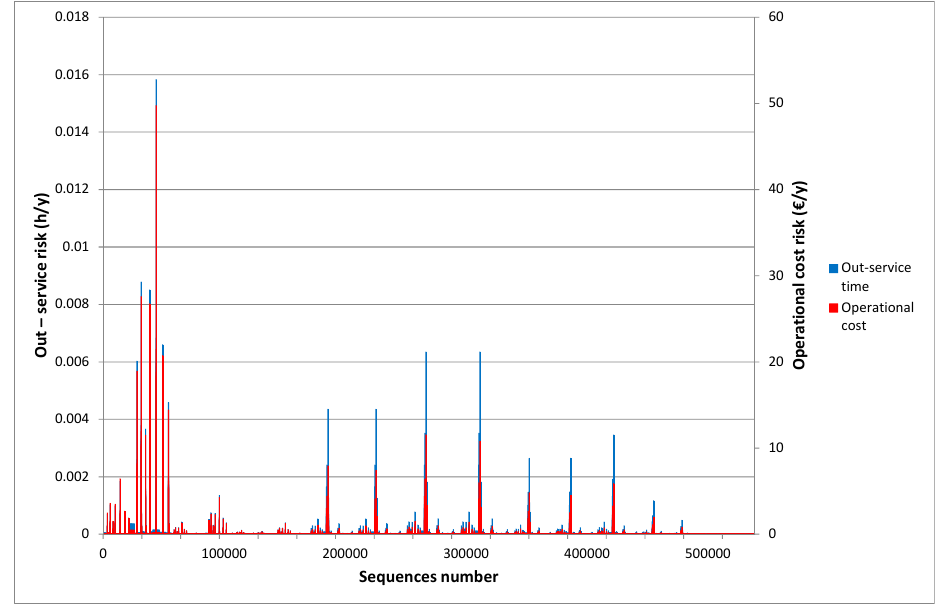
Figure 8. The risk of the sequences of events contain the high concentration of VOCs in the output for the reverse flow plant.